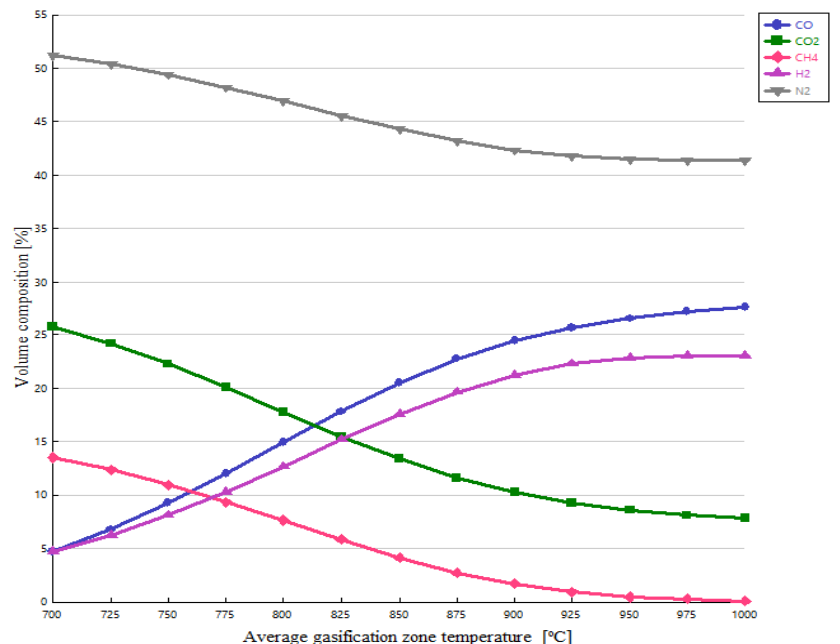
Figure 6. Syngas composition as a function of gasification temperature.